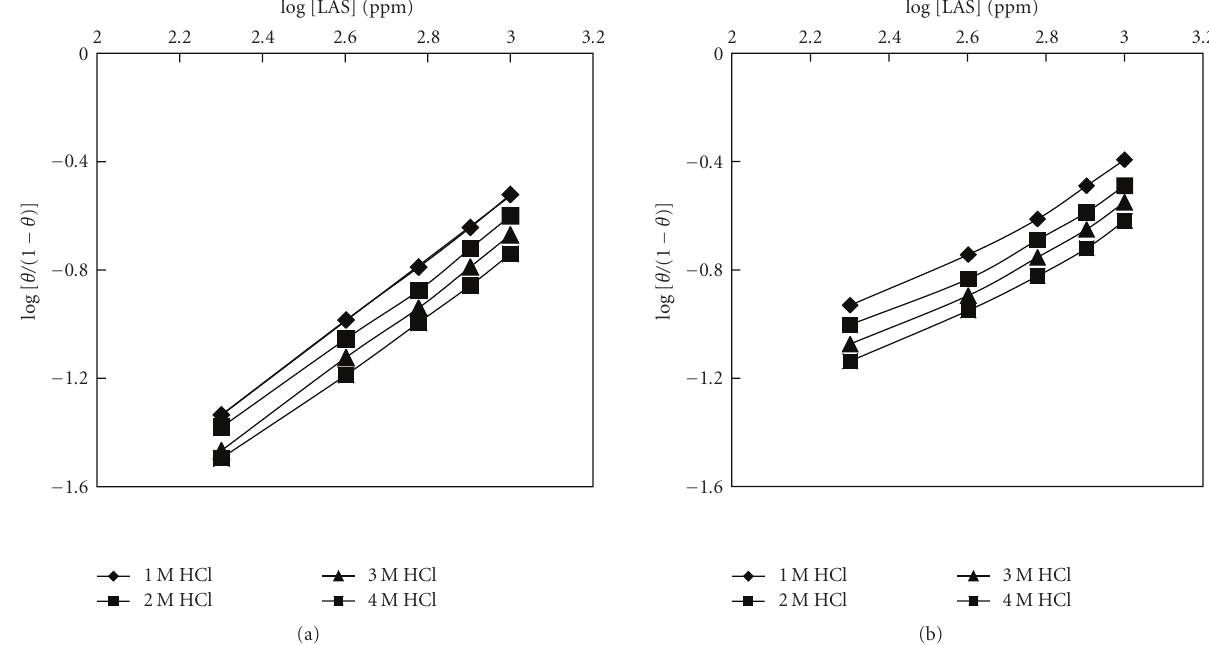
Figure 4: Langmuir isotherm curves (a) in the absence of magnetic field and (b) in the presence of magnetic field. Table 2: Kinetic and thermodynamic parameters of corrosion in HCl solution in the presence of magnetic field.